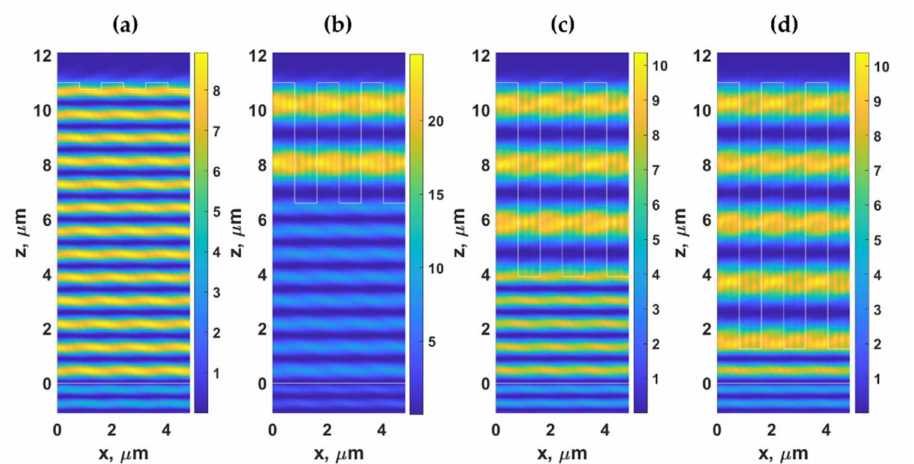
Figure 7. H 2 y field distribution calculated using RCWA for the gratings with λ g of 1.625 µ m, F.F. of 0.5, d of 11 µ m, and ( a ) d g of 0.24 µ m, ( b ) d g of 4.42 µ m, ( c ) d g of 7.11 µ m, and ( d ) d g of 9.75 µ m, when illuminated by TM polarized light at 685 nm and the n 0 sin θ 0 of